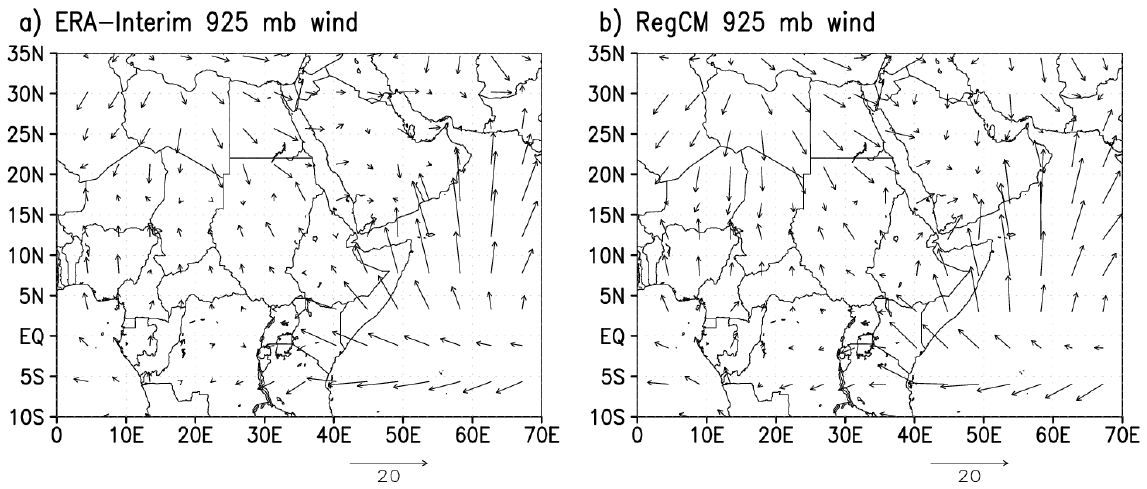
Figure 5. Averaged 925mb wind vector for JJAS 1982–2009: (a) ERA-Interim, (b) Reg-TB (ensemble average).